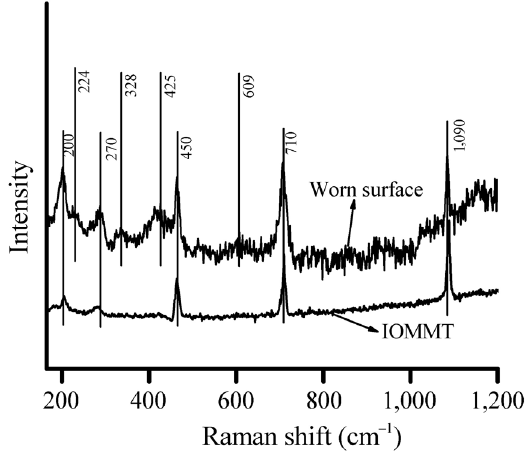
Fig. 10 Raman spectra of the nanometer IOMMT and worn surface lubricated with IOMMT grease at 200 N, 5 Hz, and RT.